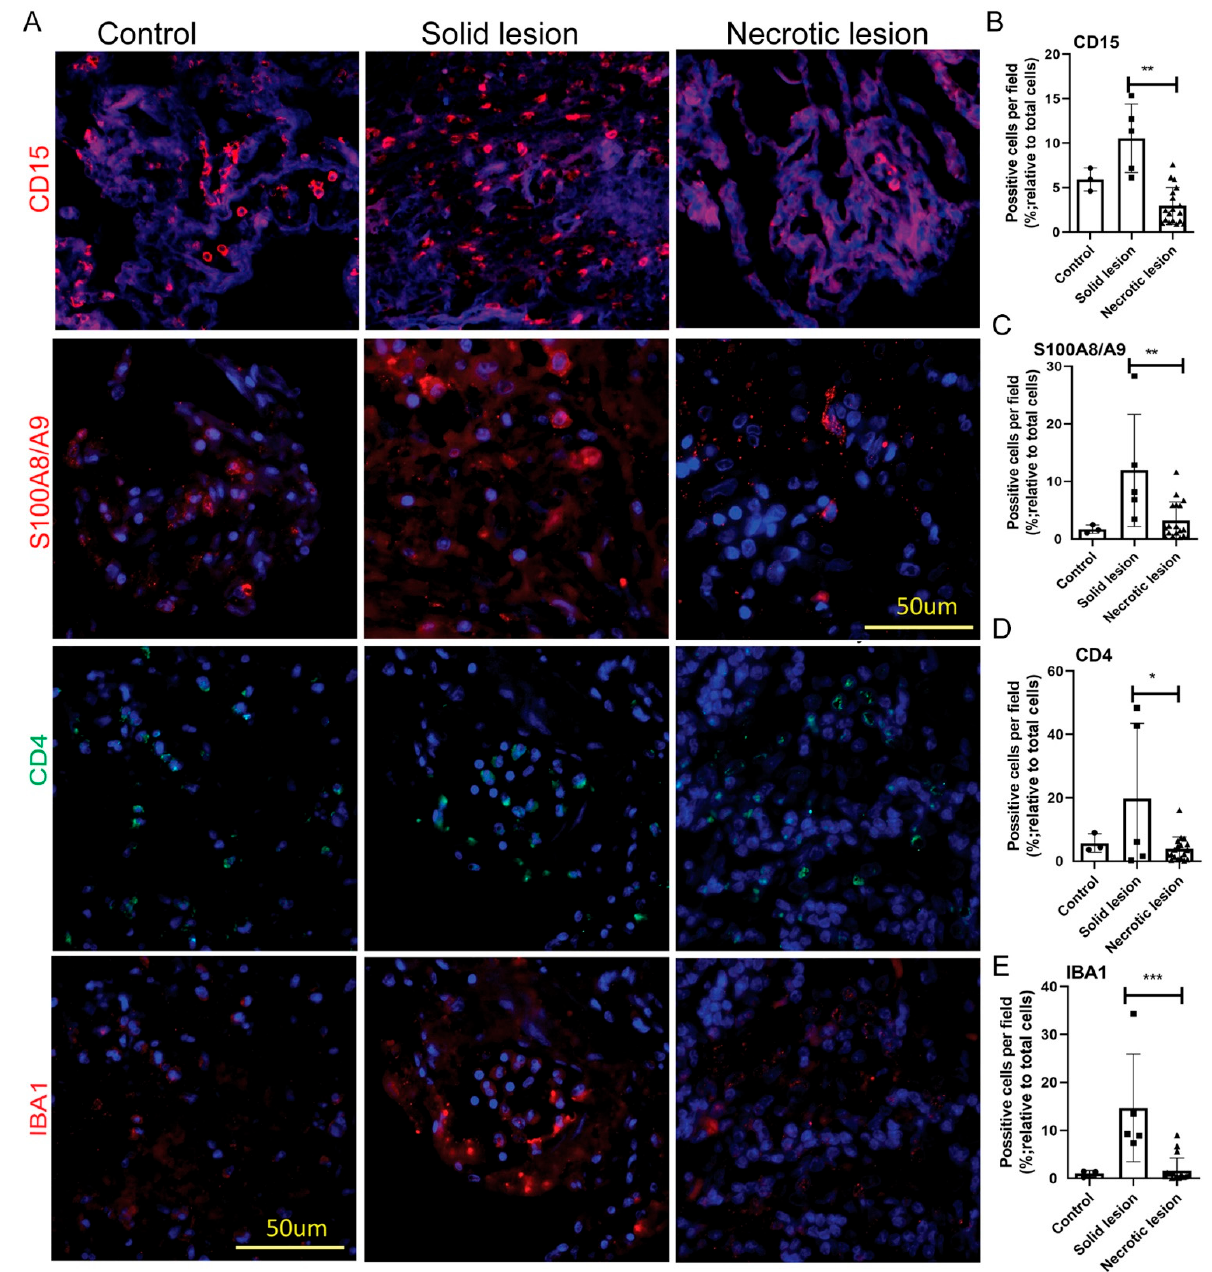
Figure 2. Distribution of CD15, S100A8/A9, CD4 and IBA1 positive immune cells in human lung TB granulomas. ( A ) Representative images singleplex (CD15 and S100A8/A9; red spots) and multiplex (CD4; green spots and IBA1; red spots) immunostaining of control, solid/non-necrotic and necrotic granulomas. Host cell nucleus is stained blue with DAPI. Scale bar in S100A8/A9 panel (50 microns) is common for CD15 and S100A8/A9 images. Scale bar in the IBA1 panel (50 microns) is common for CD4 and IBA1 images. ( B ) Distribution of CD15 positive cells (including MDSCs) relative to the total number of cells in the field in control, solid/non-necrotic granulomas and necrotic granulomas. ( C ) Distribution of S100A8/A9 positive cells (mainly neutrophils) relative to the total number of cells in the field in control, solid/non-necrotic granulomas and necrotic granulomas. ( D ) Distribution of CD4 positive T-cells relative to the total number of cells in the field in control, solid/non-necrotic granulomas and necrotic granulomas. ( E ) Distribution of IBA1 positive cells (activated macrophages) relative to the total number of cells in the field in control, solid/non-necrotic granulomas and necrotic granulomas. Data plotted in ( B – E ) are mean and standard error mean (SEM) of n = 3 (control); n = 5 (solid lesion) and n = 18 (necrotic lesion). Data were analyzed by One-way ANOVA with Tukey’s post-hoc correction for multiple group comparison; * p < 0.05; ** p < 0.01; *** p <